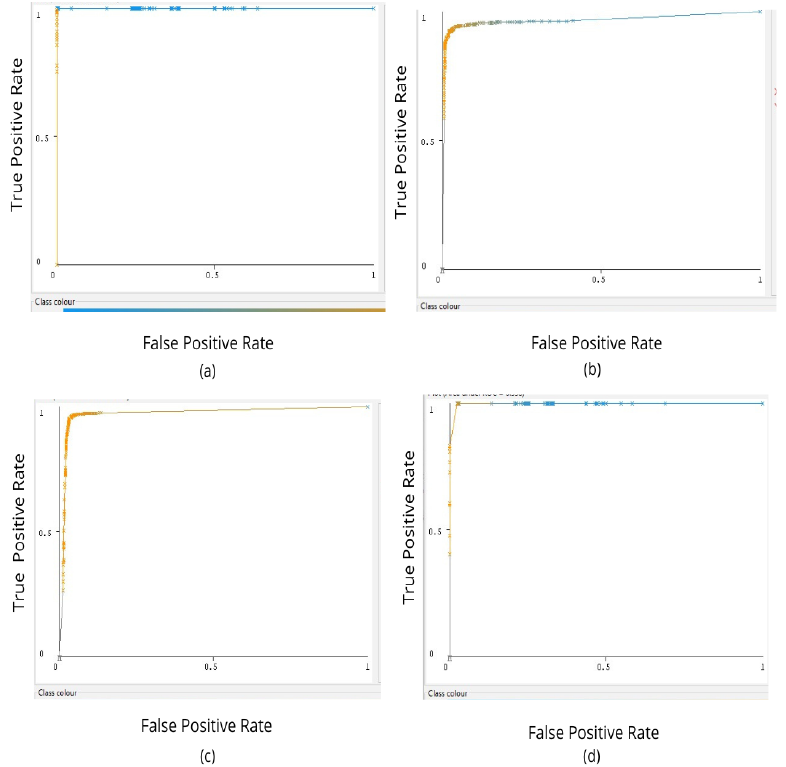
Figure 8. ROC-AUC of ReSVM using ( a ) SFDDD dataset, ( b ) BU dataset, ( c ) DrivFace dataset, and ( d ) FT-UMT dataset.